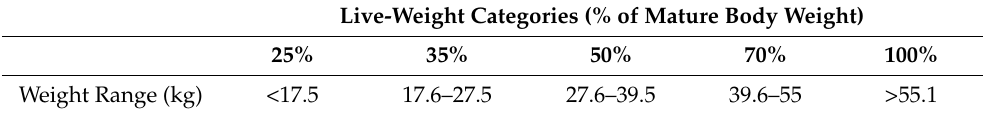
Table 1. Weight range per live-weight category